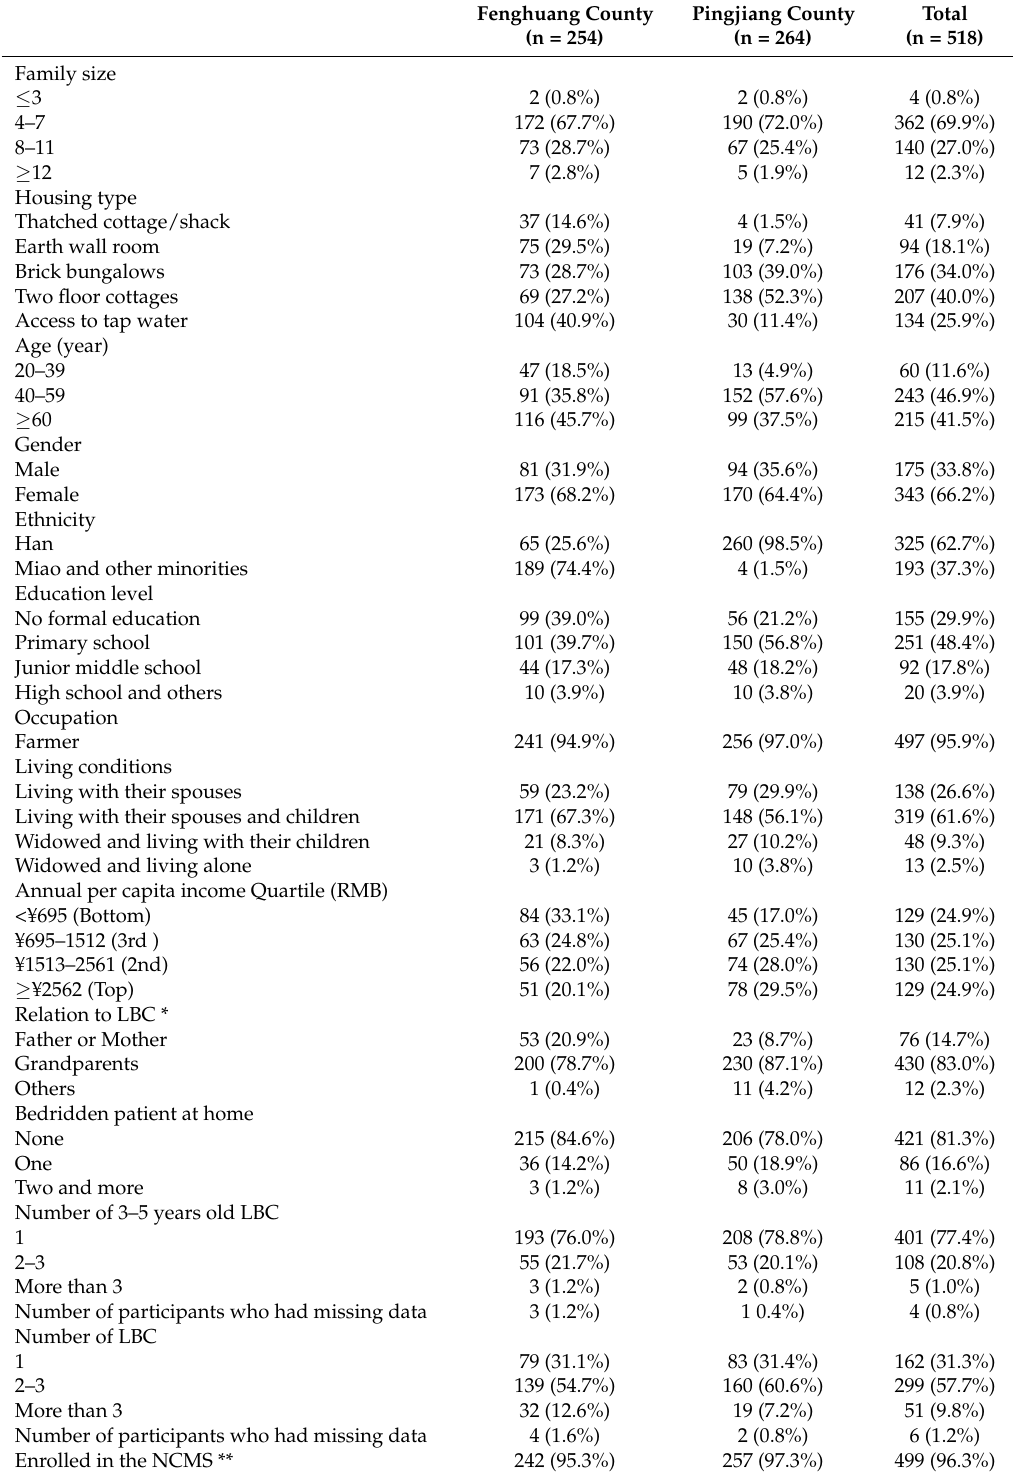
Table 1. Socio-demographic characteristics of study population (n,